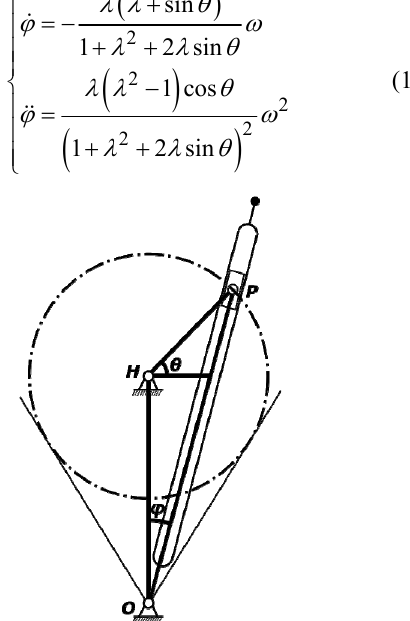
Figure 3. Kinematic schematization of the quick return mechanism Thus, once the angular position θ , the angular velocity ω θ = (cid:5) , and the angular acceleration α θ = (cid:5)(cid:5)